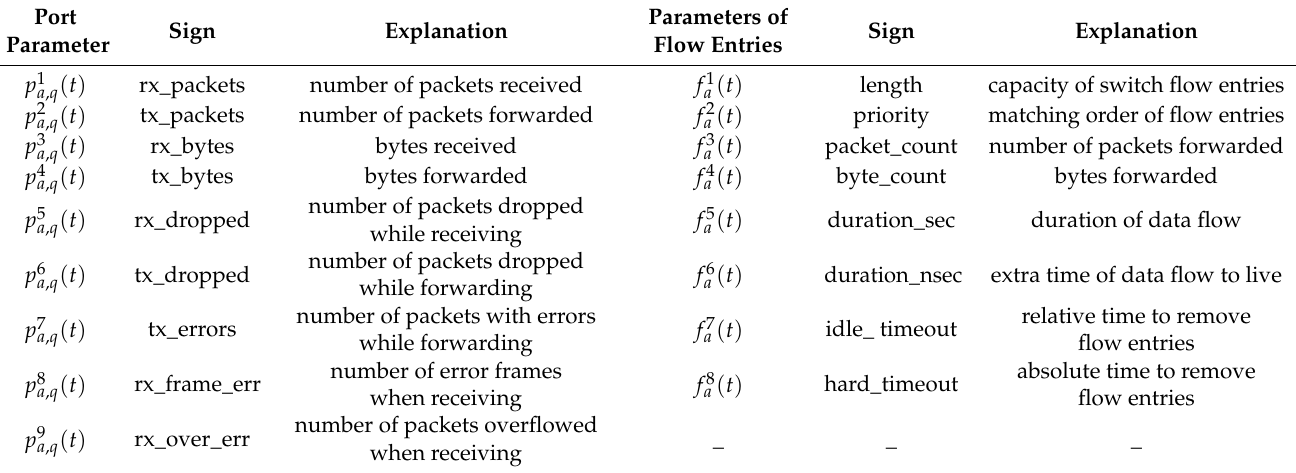
Table 2. The port parameter of the SDN switch and status parameters of the flow entries in the LoRaWAN.